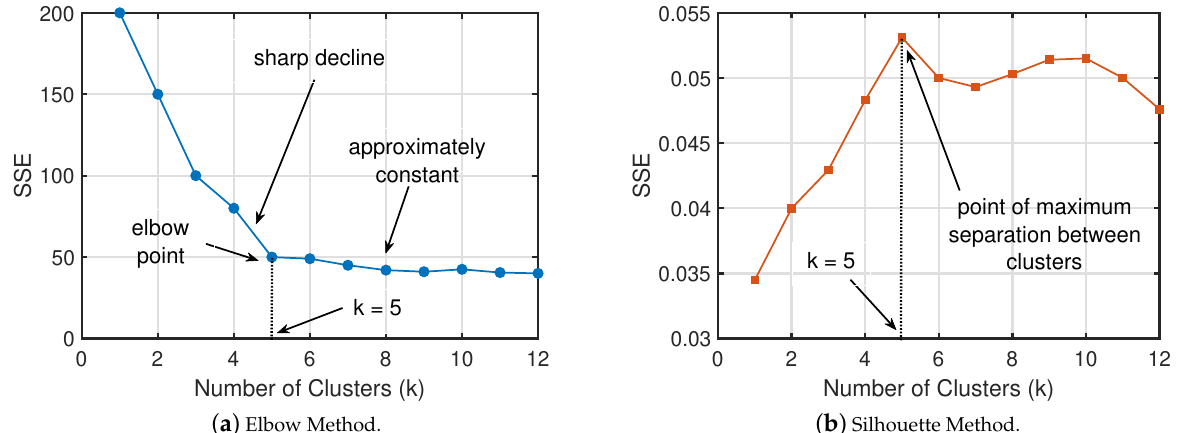
Figure 5. Elbow and Silhouette are complementary methods to determine the optimal number of clusters. Both methods ideally tend to converge to the same k, e.g., k = 5 in the